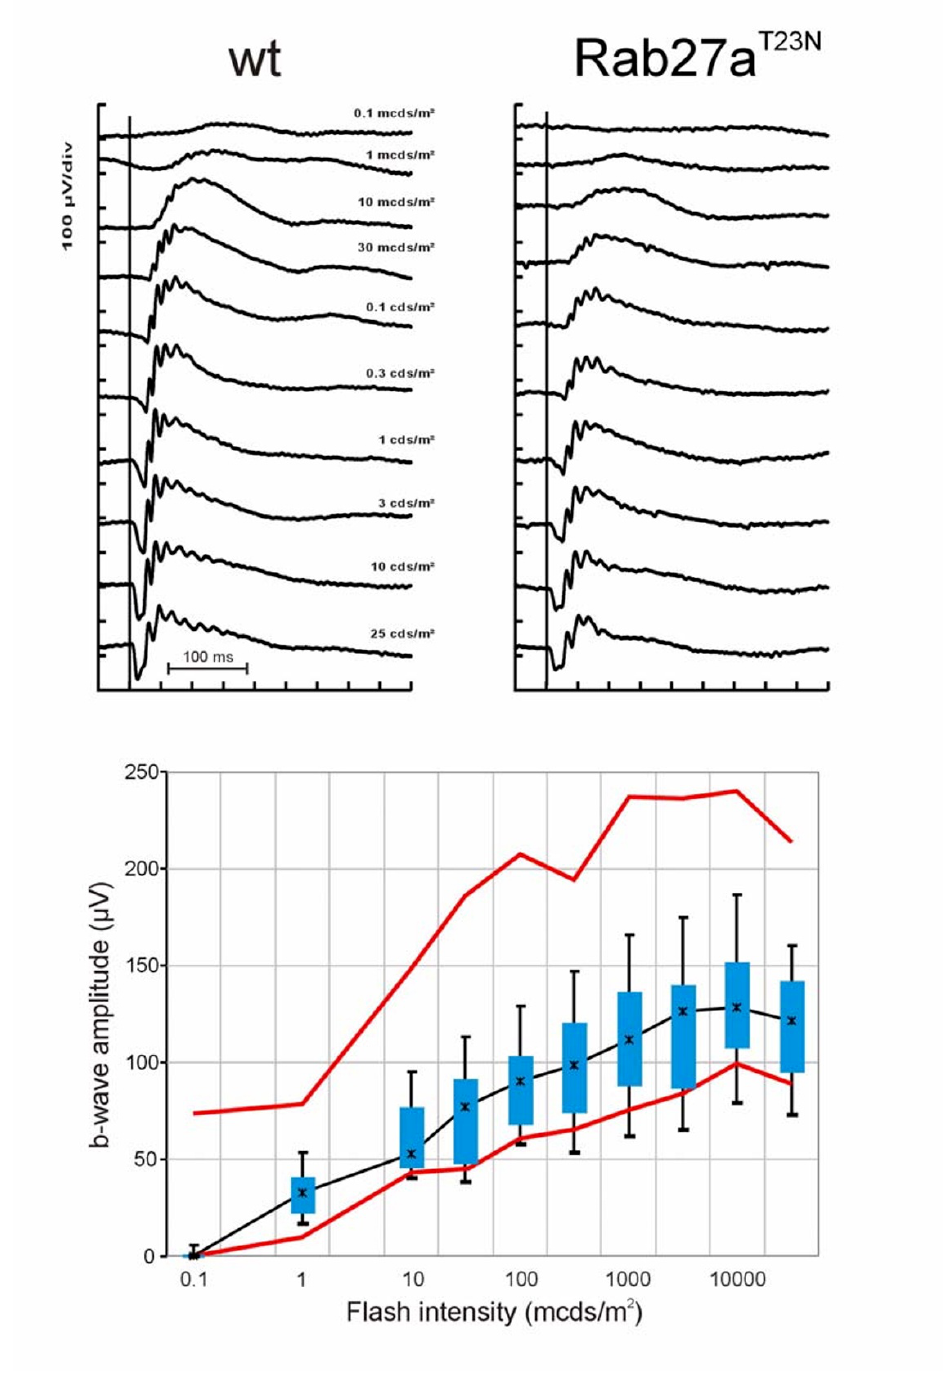
Figure 9 Electrophysiological characteristics of the A27aT25/2 transgenic mouse line. (Panel A) Dark-adapted (scotopic) intensity series of a six month-old wild-type control (left column) and a A27aT25/2 transgenic mouse (right column). Calibration marks: Verti- cal 100 µ V/div.; horizontal 40 ms/div. Stimulus intensities increased from top to bottom from 10 -4 to 25 cd*s/m 2 . (Panel B) Amplitude vs. intensity plot for the A27aT25/2 transgenic line in comparison to wild type mice. The crosses indicate the median, the boxes the 25%- to 75%-quantiles, and the whiskers the 5%- to 95%-quantiles. The upper (95% quantile) and lower (5% quantile) red line indicate the normal range based on wild type